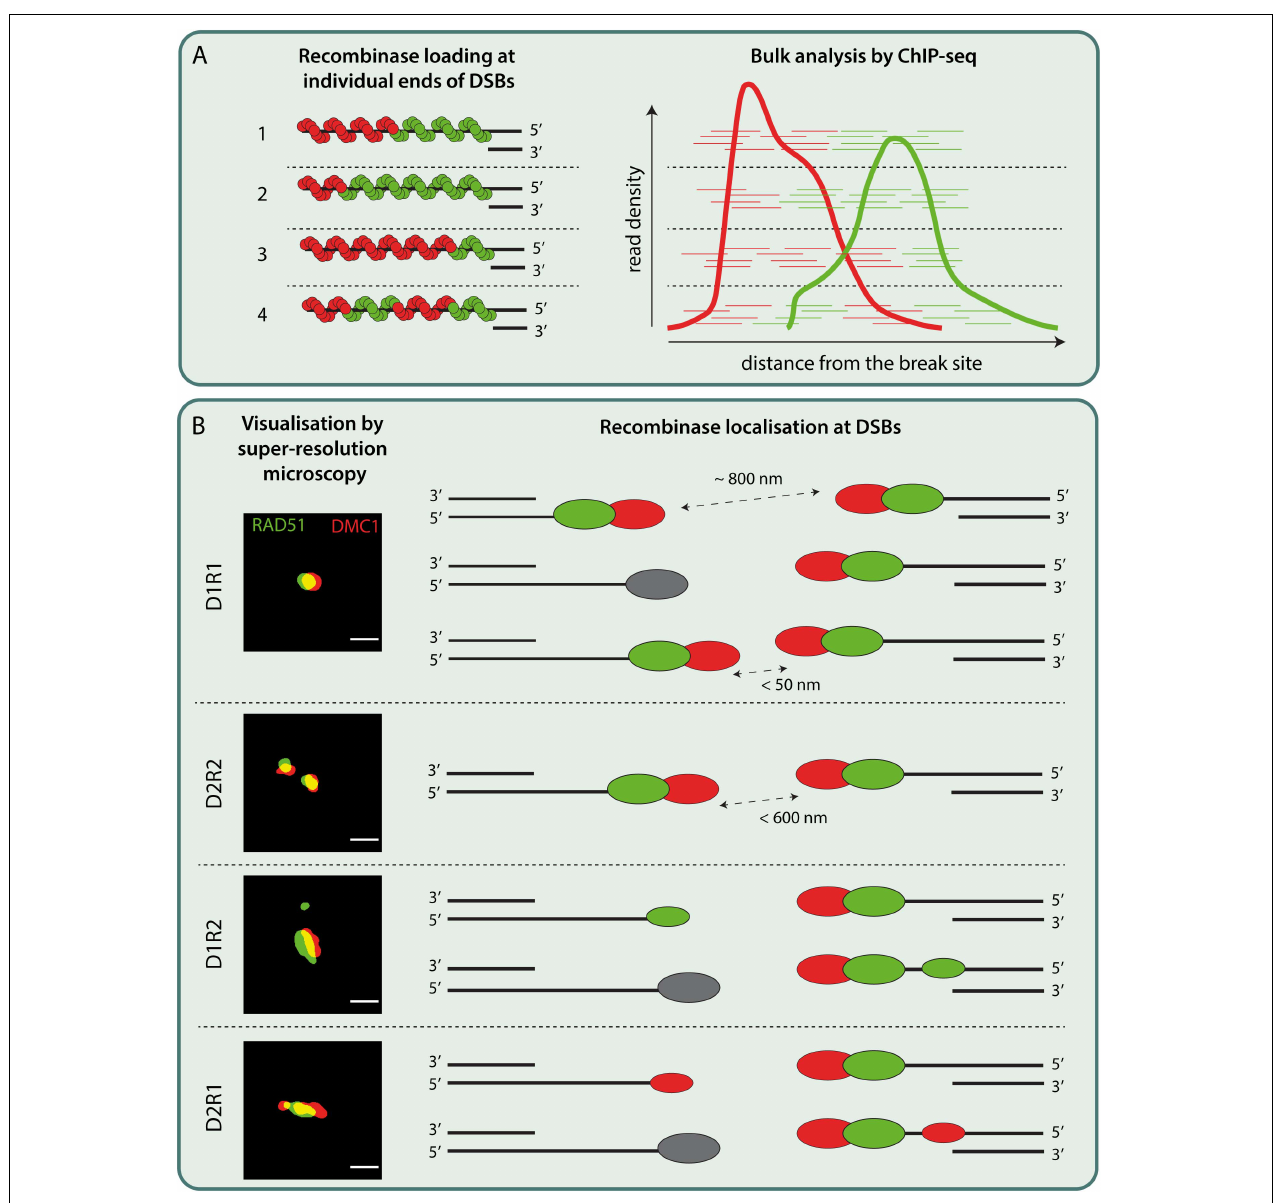
FIGURE 2 | Schematic models interpreting bulk and single-cell data on recombinase loading at individual DSBs in mouse meiosis. (A) (left)The location of initial RAD51 and DMC1 loading on ssDNA might be random. The suggested directionality to their filament formation (Brown and Bishop, 2014) could subsequently lead to the RAD51 filaments extending in 3 (cid:48) –5 (cid:48) direction while DMC1 filaments extending in 5 (cid:48) –3 (cid:48) direction. The resulting ssDNA would then be occupied with a varying composition of RAD51 and DMC1 recombinases as represented in 1–3. It is equally possible that multiple short stretches of RAD51 and DMC1 filaments are assembled on ssDNA as shown in 4. (right) is a schematic drawing of putative RAD51 and DMC1 ChIP-seq reads corresponding to their loading on individual break sites as depicted in 1–4. The bulk cell nature of ChIP-seq analysis would then yield density plots as indicated in the cartoon, inspired from the RAD51 and DMC1 ChIP-seq analysis from Hinch et al. (2020). (B) Super-resolution imaging of DSB repair foci in mice revealed various configurations of DMC1 (D, red oval) and RAD51 (R, green oval). The most frequent configuration, D1R1, can be interpreted in three ways: Assuming that the recombinase foci with a preferred nearest neighbor distance of around ∼ 800 nm (Slotman et al., 2020) represent two ends of DSB, D1R1 can be interpreted as DMC1-RAD51 pairs loaded symmetrically across two ends of DSB. Alternatively, D1R1 configuration might also be the result of two ends of DSB each loaded with DMC1-RAD51 pairs that end up so close ( < 50 nm) that they could not be resolved even with super-resolution microscopy. It is equally possible that one end of DSB might be occupied by other ssDNA binding proteins or is being processed while the other end is loaded with DMC1-RAD51 pair. Secondly, based on the paired foci observed in other species and according to ChIP-seq data, a D2R2 can be interpreted as a subset of D1R1 loaded ends of a DSB that lie within the ROI ( < 600 nm). However, this configuration is rare. Besides these configurations, other configurations such as D2R1 and D1R2 (of which D2R1 is the second most frequent configuration) consisting of a smaller DMC1 or RAD51 foci along with a D1R1 have been observed rather frequently. These configurations may be interpreted as the presence of a single DMC1 or RAD51 focus on the other end of DSB occupied by a D1R1, or an extra focus on the same ssDNA accommodating a D1R1. Other interpretations of these recombinase configurations are also possible. ROI: region of interest Scale bar representing 250 nm. Binary super-resolution images of RAD51 and DMC1 configurations are derived from Slotman et al. (2020).